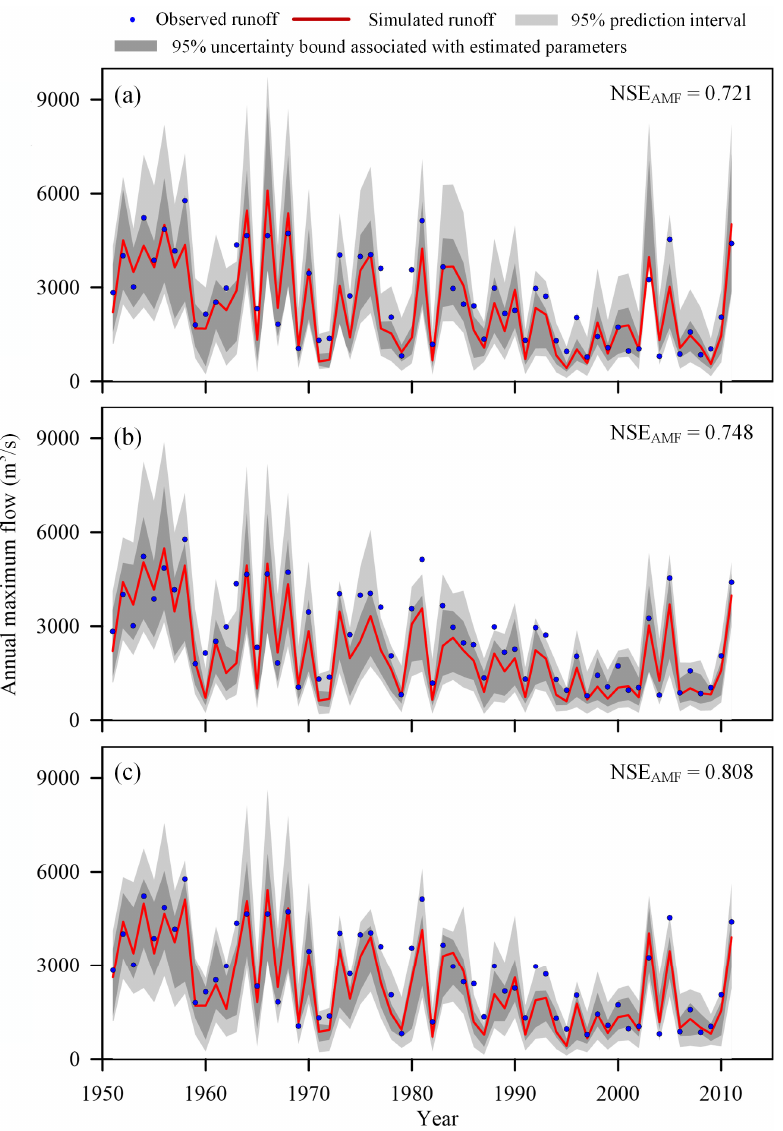
Figure 4. Comparison of the observed and simulated annual maximum flow. ( a – c ) represent model zero, one and two, respectively. zero, one and two,